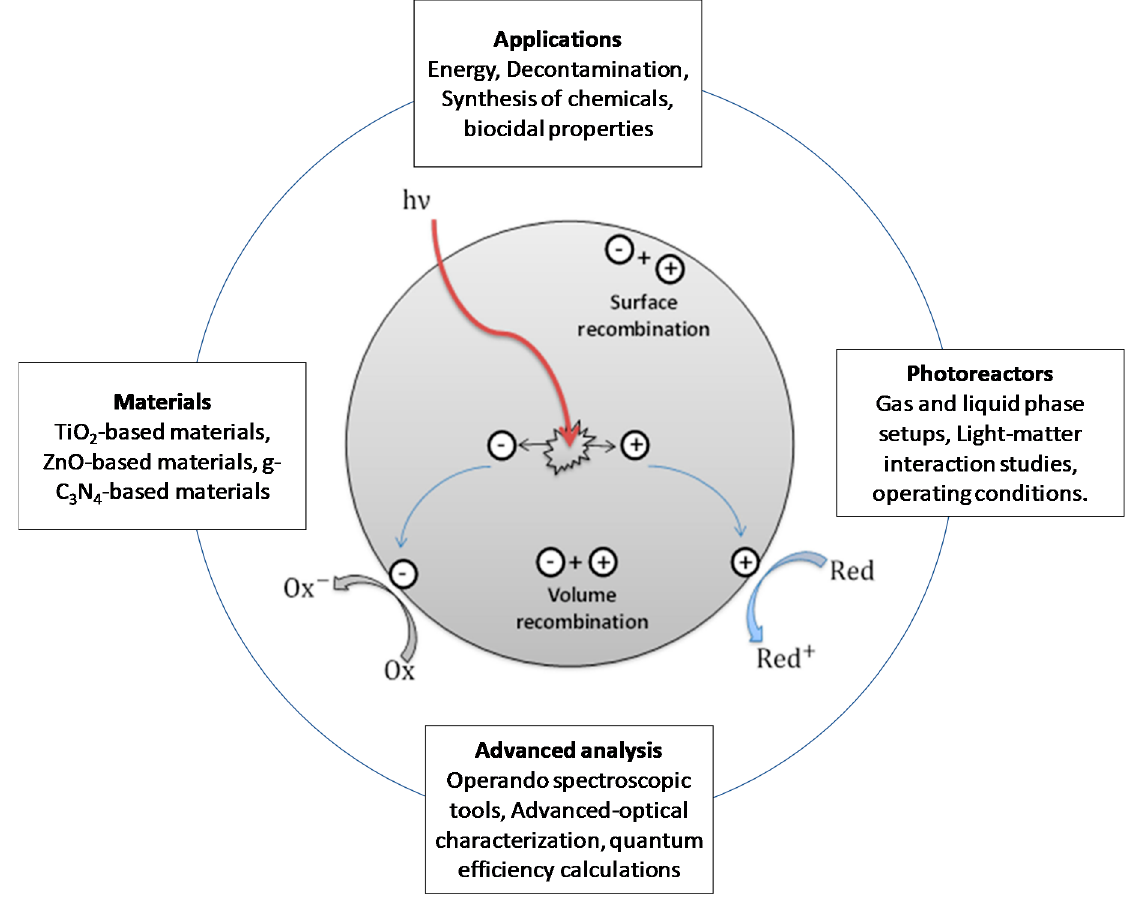
Figure 1. Schematic representation of the photo-activation and primary reaction steps of a semiconductor and the main open research lines in the photocatalysis field.